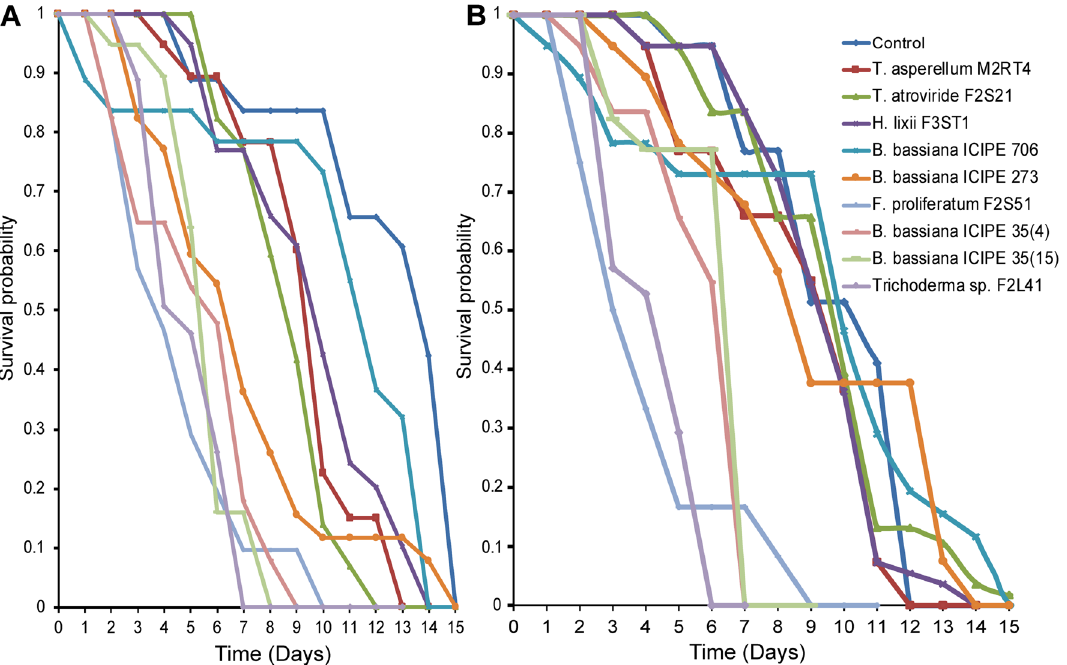
Figure 5. Effect of endophytically-colonized host plants by fungal isolates on Tuta absoluta F1 progenies survival. ( A ) Kaplan–Meier survival curves of Tuta absoluta F1 progenies survival emerging from endophytically-colonized tomato plants. ( B ) Kaplan–Meier survival curves of Tuta absoluta F1 progenies survival emerging from endophytically-colonized nightshade plants ( P < 0.05, n =